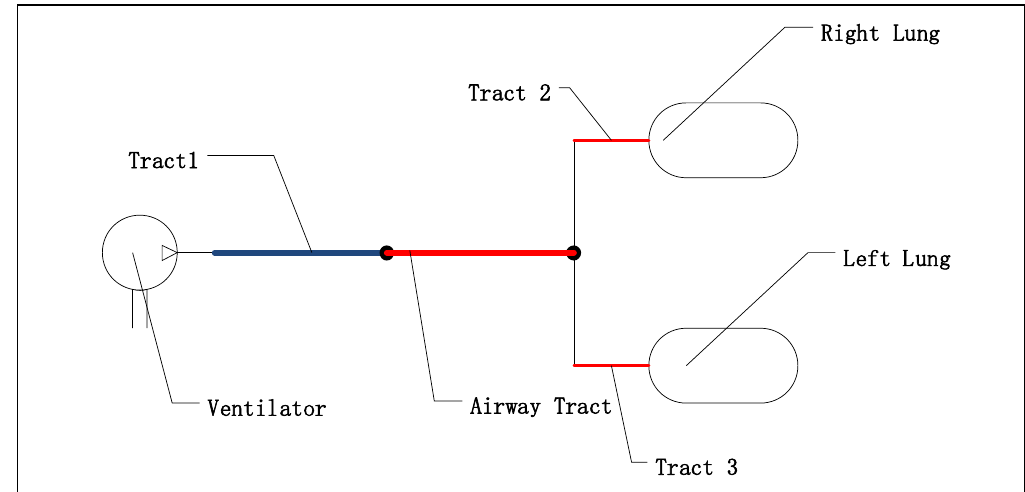
Figure 1 . Simplified mechanical ventilation system.